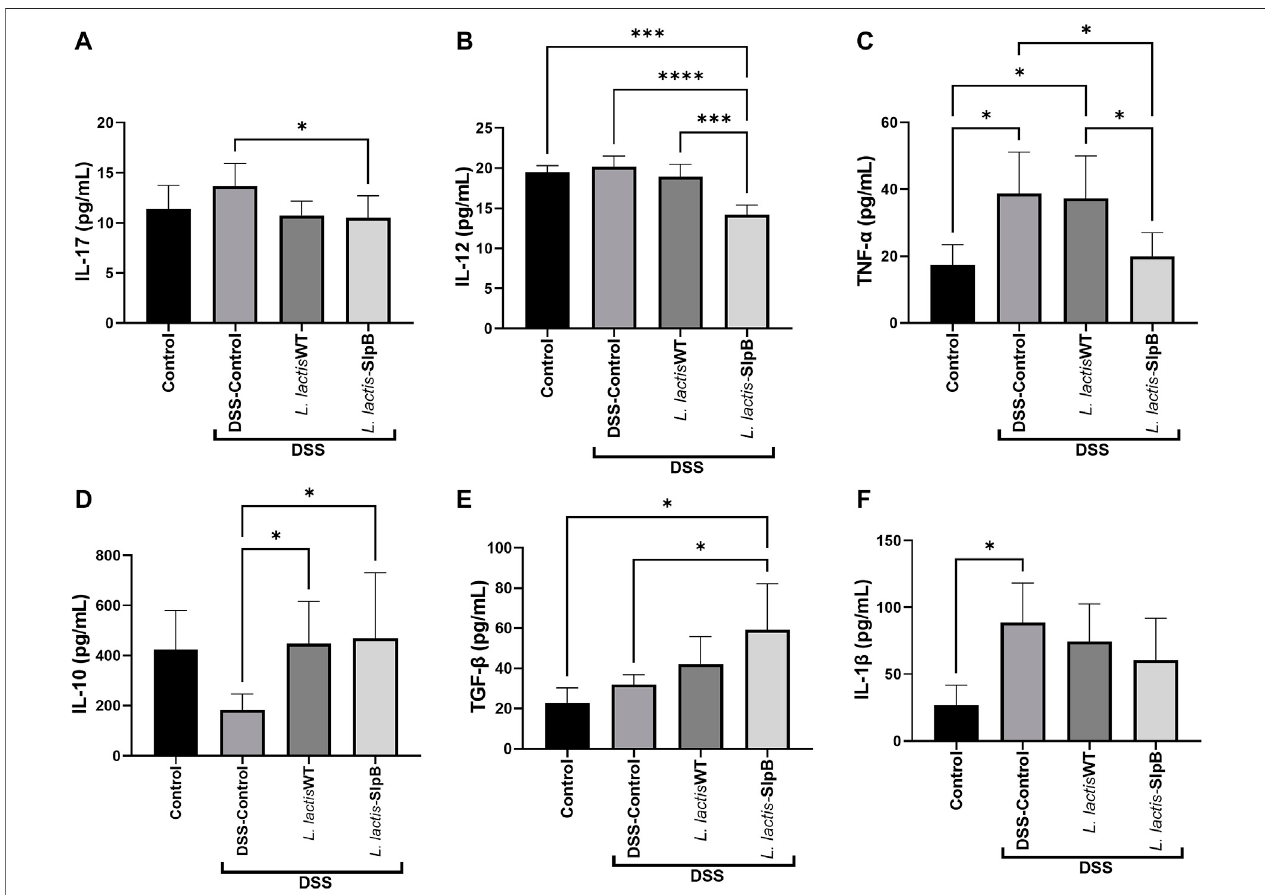
FIGURE7| L.lactis -SlpBstrainmodulatescytokinesproductioninthemicecolon.ColoniccytokinesconcentrationslevelsofIL-17 (A) ,IL-12 (B) ,TNF- α , (C) ,IL-10 (D) , TGF- β (E) , IL-1 β (F) were quanti fi ed by enzyme-linked immunosorbent assay (ELISA). The data represent the mean ± SD of six mice per group. One-way ANOVA and Tukey ’ s post - hoc tests wereused formultiple comparisons.Asterisks represent statistically signi fi cantdifferences asfollows: p p < 0.05, pp p < 0.01, ppp p < 0.001, pppp p < 0.0001.